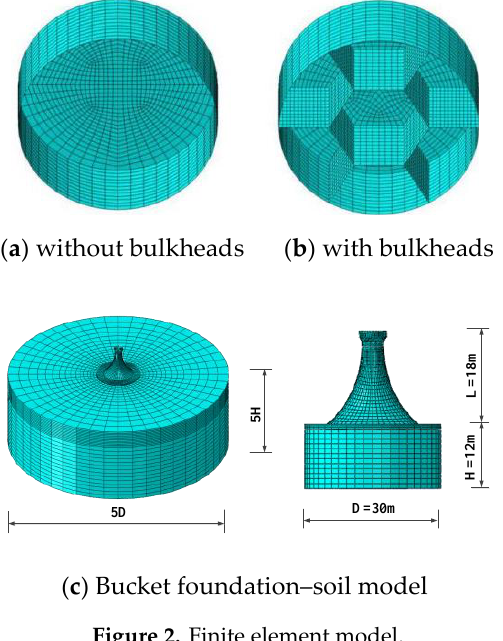
Figure 2. Finite element model.